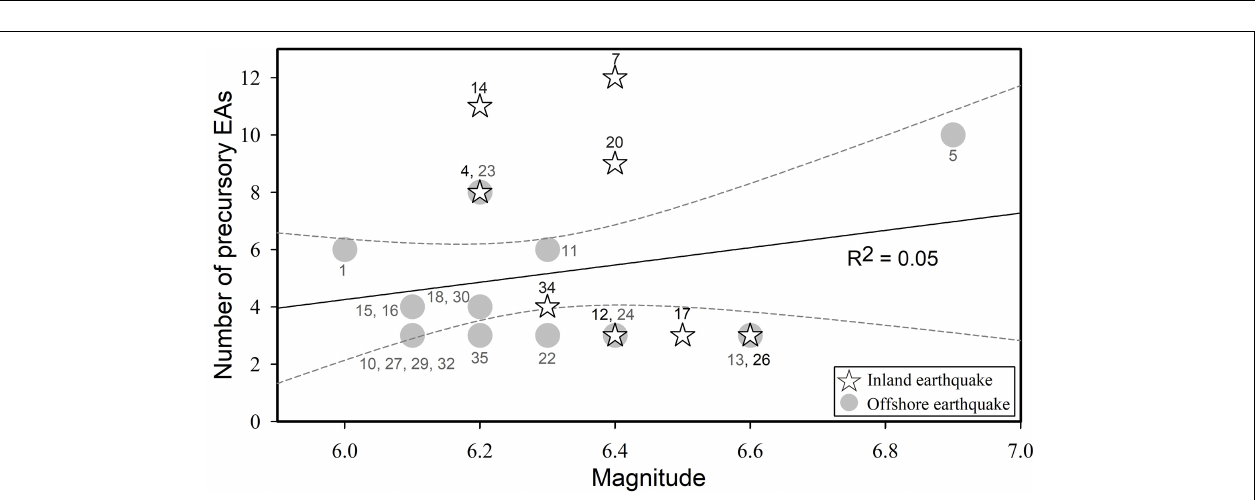
FIGURE 4 | Temporal profile of daily OLR E Index anomalies (EA) associated with each precursory event within 25 days before and after the earthquake. The black and gray bars denote the EAs in the daytime and the nighttime, respectively.